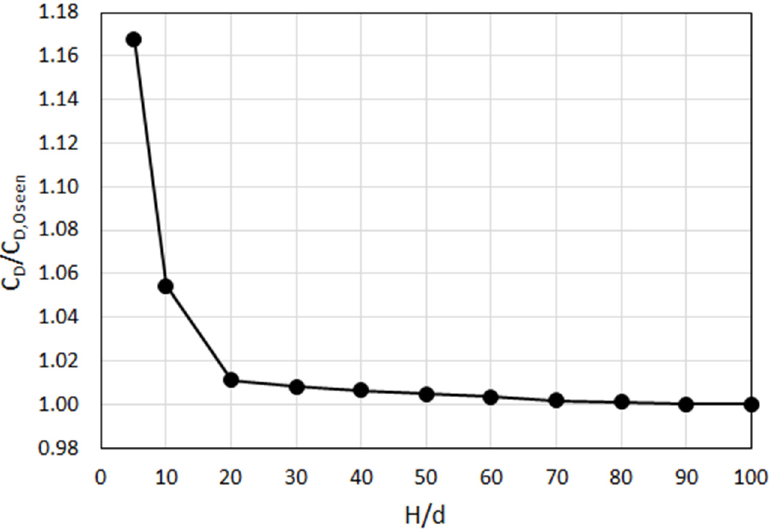
Figure 6. Variation of normalized drag coefficient with domain size for sphere with diameter d, for Re = 0.001 (achievement of the value of unity verifies the approach by manifesting its agreement with the Oseen theory).